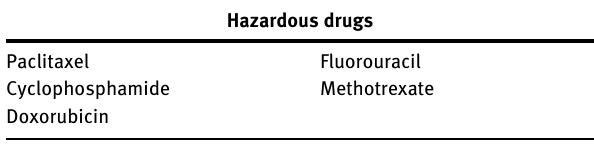
Table  : Drug and sample